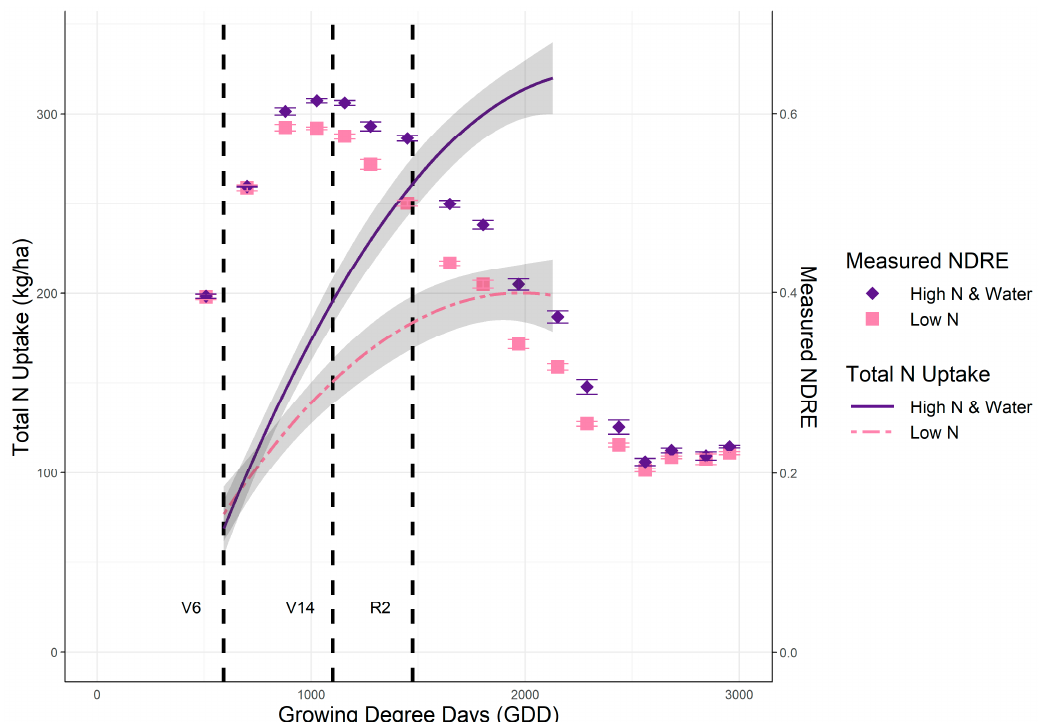
Figure 3. Changes in normalized difference red-edge (NDRE) reflectance and total nitrogen (N) uptake across the season (measured in GDD) for the low nitrogen treatment and the unstressed treatment at the experimental site (Russell Ranch 2018). Total N uptake curves are shown with confidence intervals ( α = 0.05) and NDRE measurements are shown with standard error bars. Vertical dashed black lines indicate the timing of growth stages (V6, V14, and R2) at the experimental site.